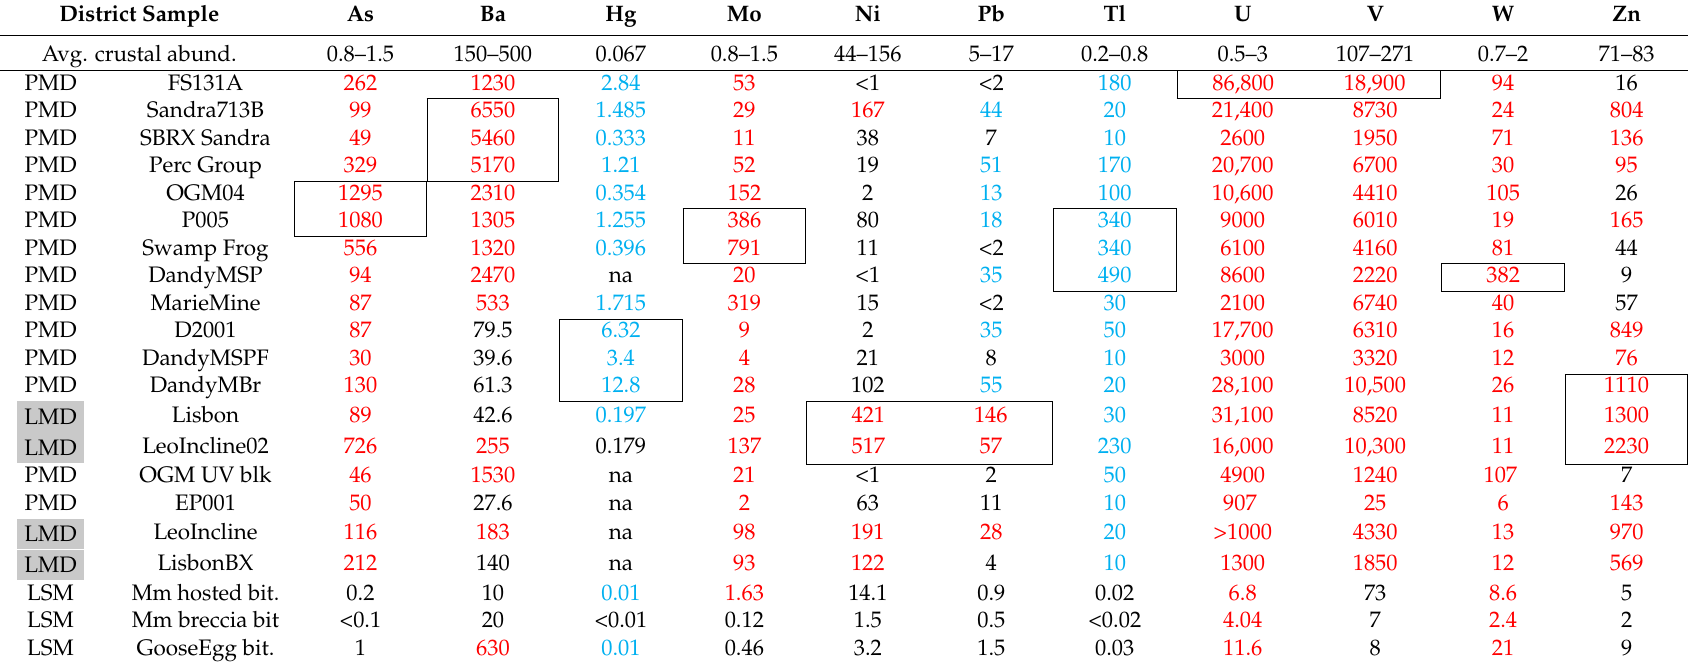
Table 2. U-V breccia samples contain elevated concentrations of many of the same elements detected in the Permian Phosphoria Formation samples collected by the USGS. Elements that are elevated greater than the average crustal abundance are shown in red and blue highlighted text in the table. Highest values are outlined in black boxes. The samples listed are the U-V breccias except the bottom three samples which are the bitumen samples. The average crustal abundances for these elements are listed in the second row. Values are in